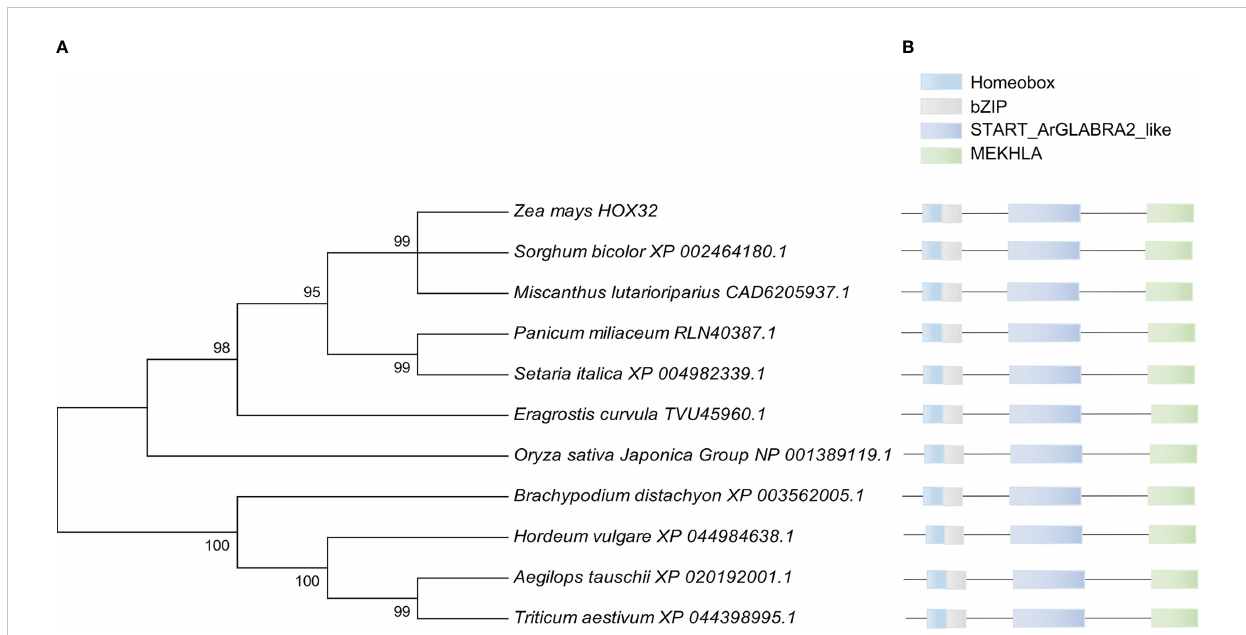
FIGURE 1 Phylogenetic tree and conserved domain analysis of ZmHOX32 with different plants. (A) Construction of phylogenetic tree using MEGA7. (B) Conserved domains of HOX32 proteins in different plants.